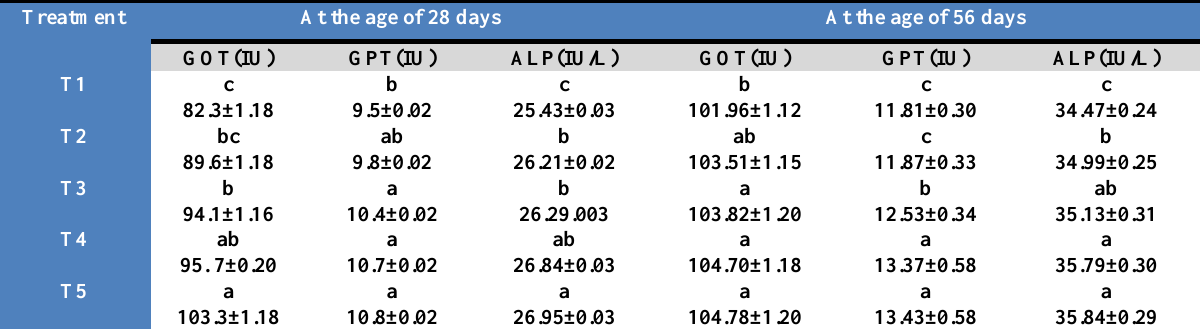
Table, 5: The effect of the addition residues of the tomato paste industry in some blood enzymes to the broiler at the age of 28 days and 56 days. Treatment At the age of 28 days At the age of 56 days GOT(IU) GPT(IU) ALP(IU/L)